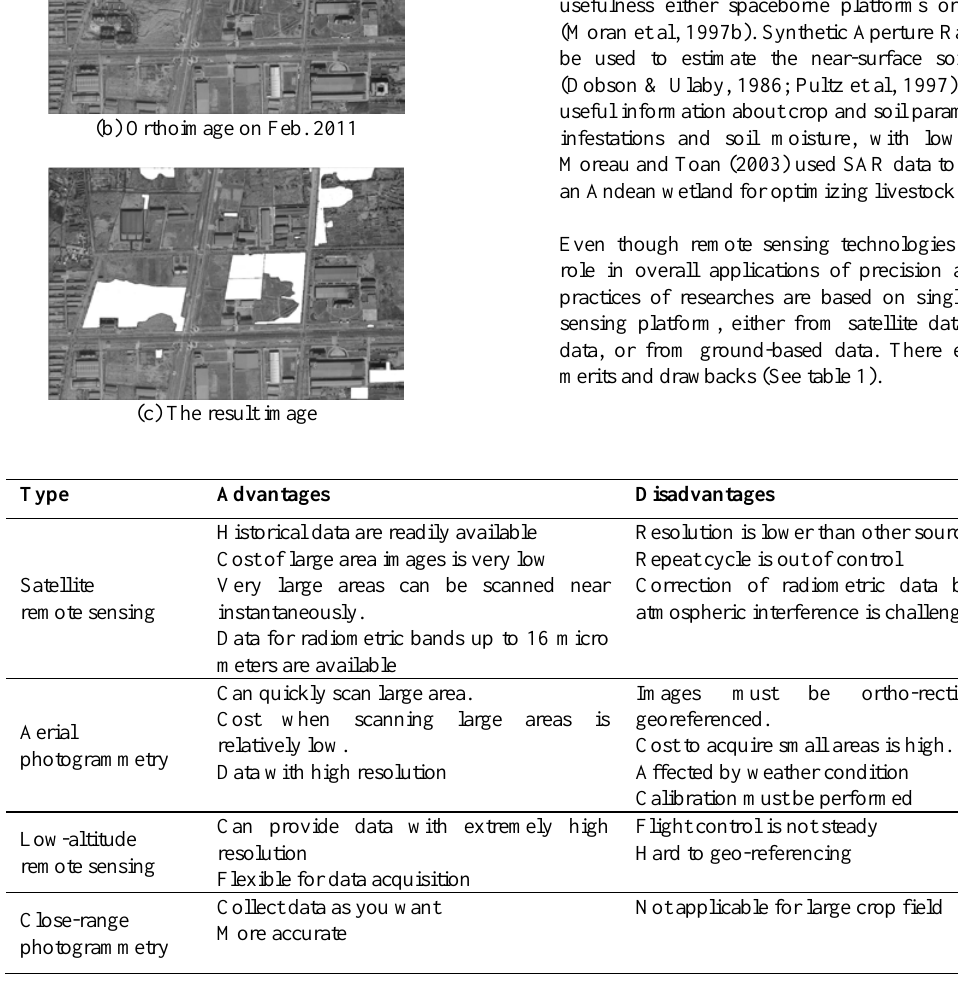
Table1. Comparisons of different remote sensing